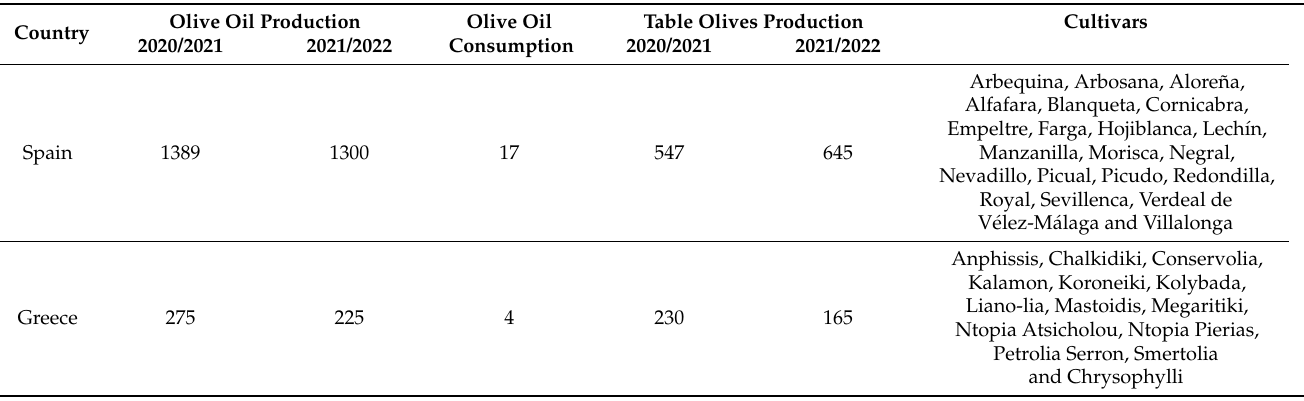
Table 1. Olive oil production ( × 1000 t) and consumption (% of world), and table olives production ( × 1000 t) in the Mediterranean countries in the last years (source: International Olive Oil Council) and main cultivars [19,22]. Na–data not available at the International Olive Oil Council. Table Olives